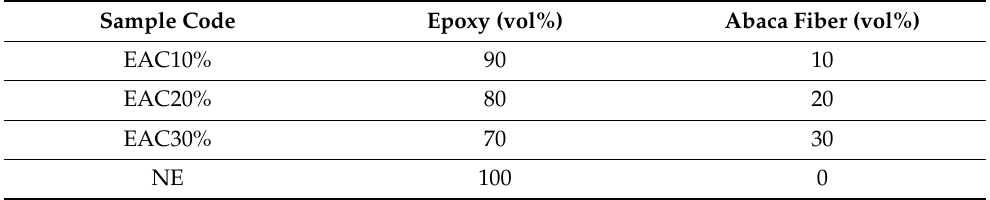
Table 1. The volume fractions of composite phases.